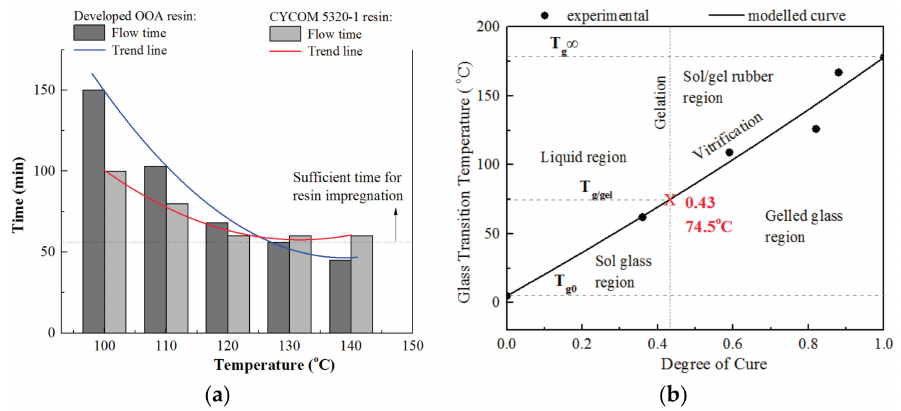
Figure 8. ( a ) Flow time of rapidly cured laminates at various isothermal temperatures; ( b ) Gelation conversion of the developed